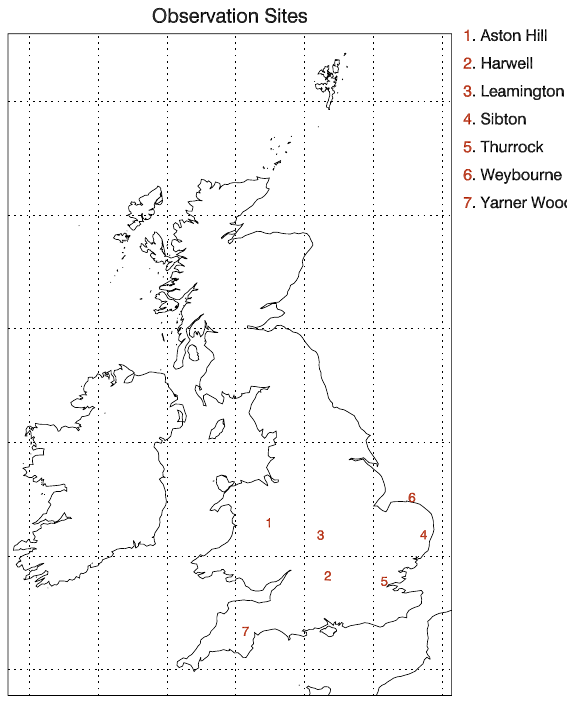
Fig. 5. Location of specific air quality observing sites in the UK referred to in the text and other Figures.